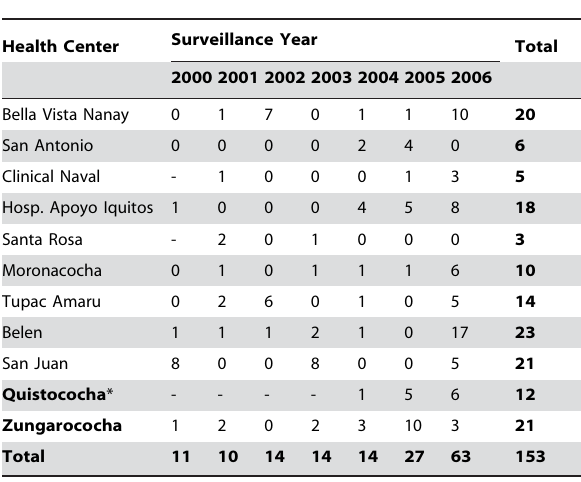
Table 1. Laboratory confirmed cases of VEEV